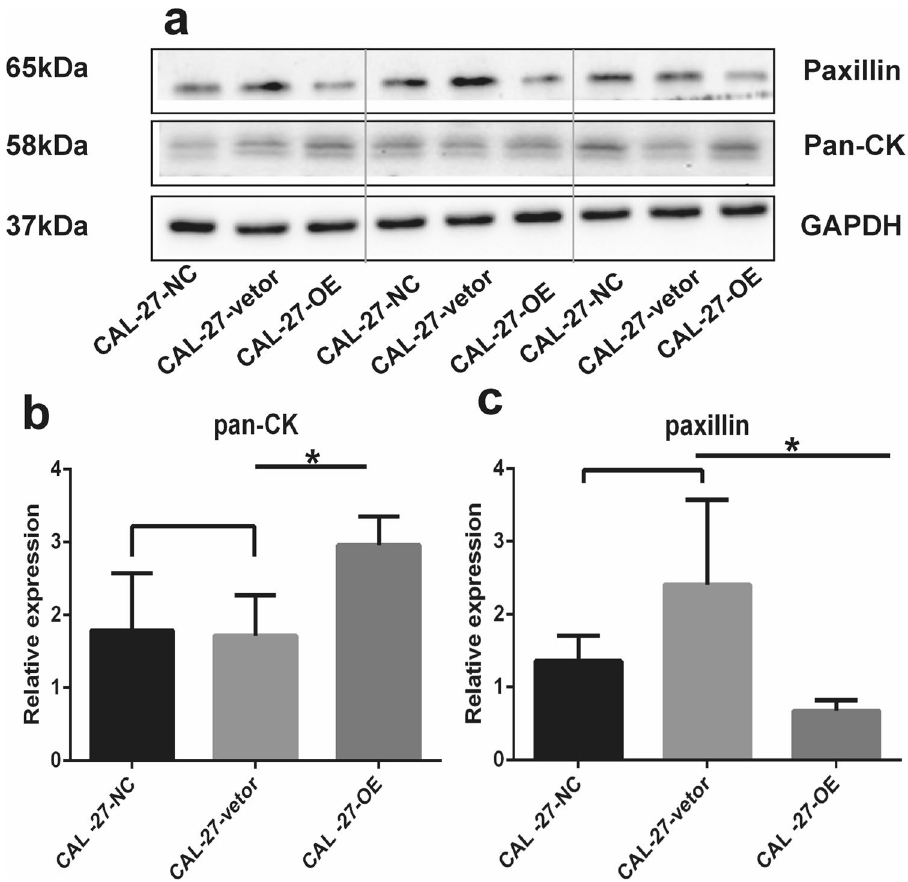
Figure 3. IFIX suppresses malignant transformation of somatic cells. ( a ) Analysis of various cytokeratins (with a pan-CK antibody) and paxillin by western blot in lysates of IFIX-overexpressing (CAL-27-OE), empty lentiviral vector (CAL-27-vector), and normal control CAL-27 cells (CAL-27-NC). Gels and blots were presented by three groups at a time and the blots were cut prior to hybridisation with antibodies during blotting. ( b , c ) The data were replicated twice in one test and presented as the mean ± SD; * P <